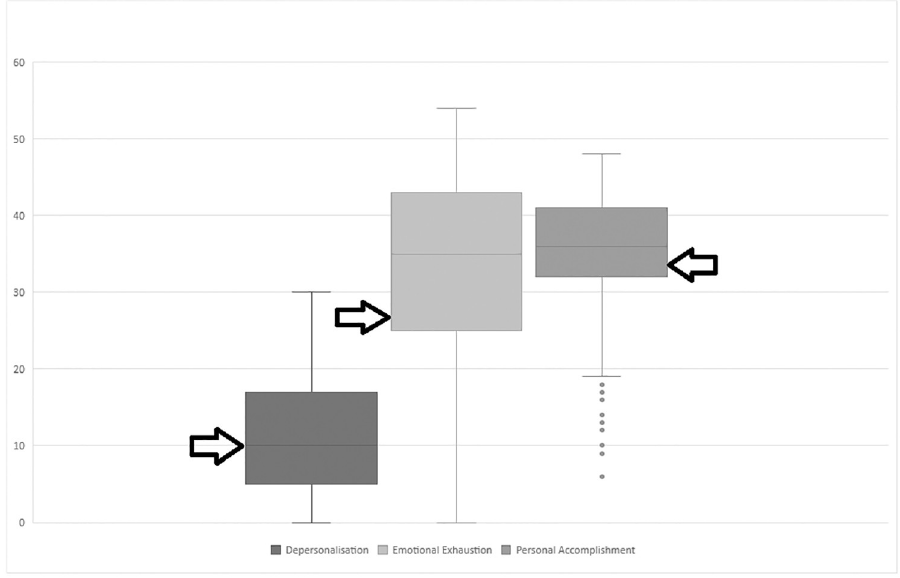
Fig 1. Box plots of the scores by domain of the Maslach Burnout Inventory, with the commonly used ’cut off’ for high risk for burnout scores